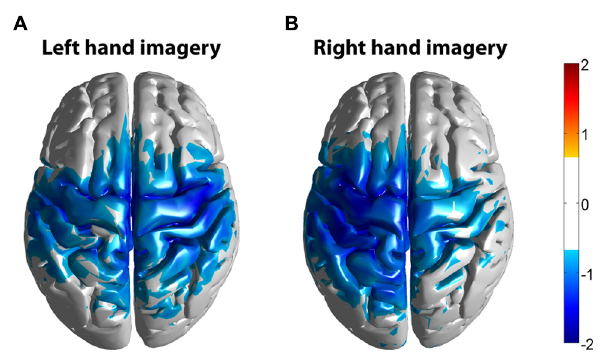
FIGURE 12 | Z -score group average maps of beta band activity (15–35 Hz) of all subjects ( n = 10). Activity was mapped in Montreal Neurological Institute (MNI) space. (A) Averaged beta activity during left hand motor imagery. (B) Averaged beta activity during right hand motor imagery.The threshold for the group average was set at Z = 0.72, corresponding to 2.3 in a normal distribution or a 99% confidence level.